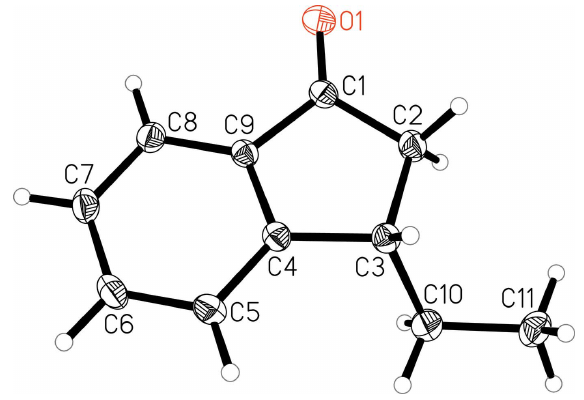
Figure 1 The molecular structure of the title compound, with displacement ellipsoids drawn at the 30% probability